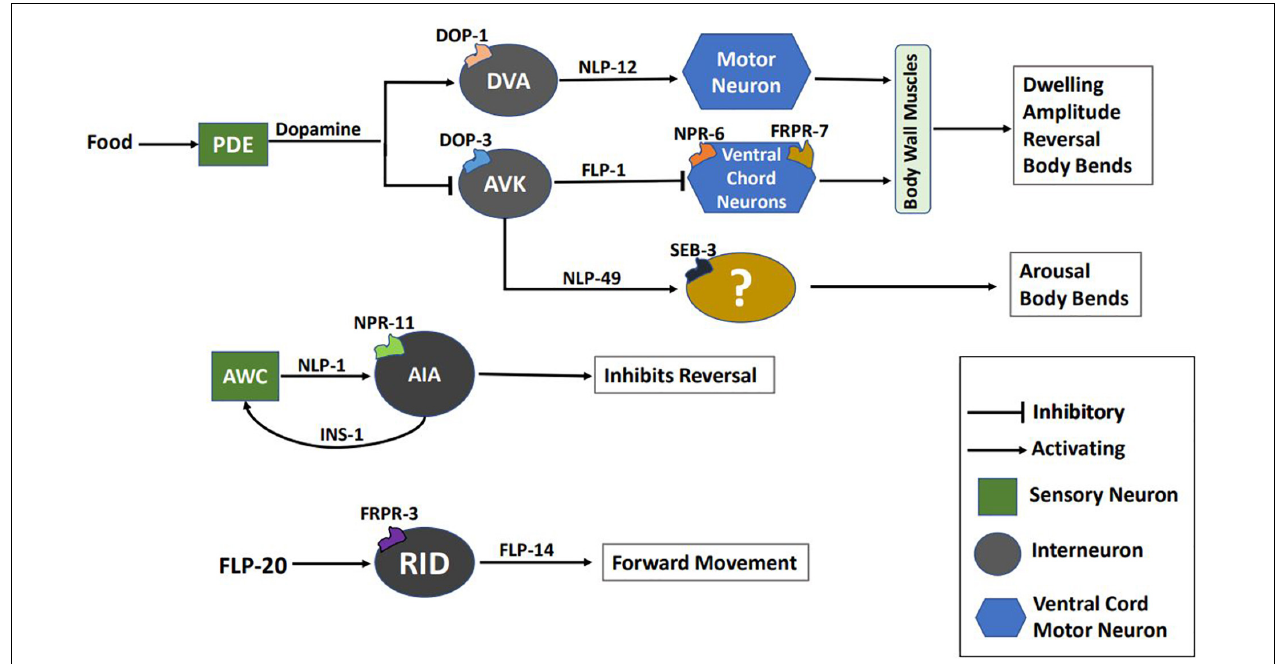
FIGURE 3 | Schematic of multiple neuropeptidergic circuits underlying locomotion. This image has been partially adapted from Oranth et al.